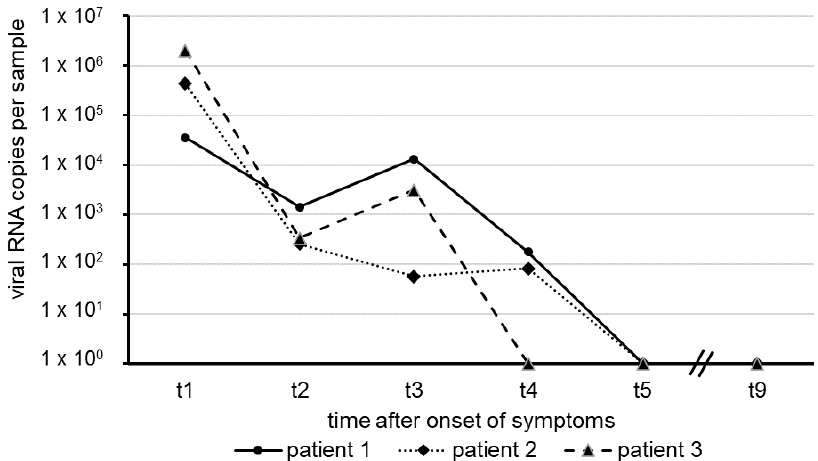
Figure 1. Time course of SARS-CoV-2 RNA detection in nasal and oro-pharyngeal swabs of three clinically ill patients.